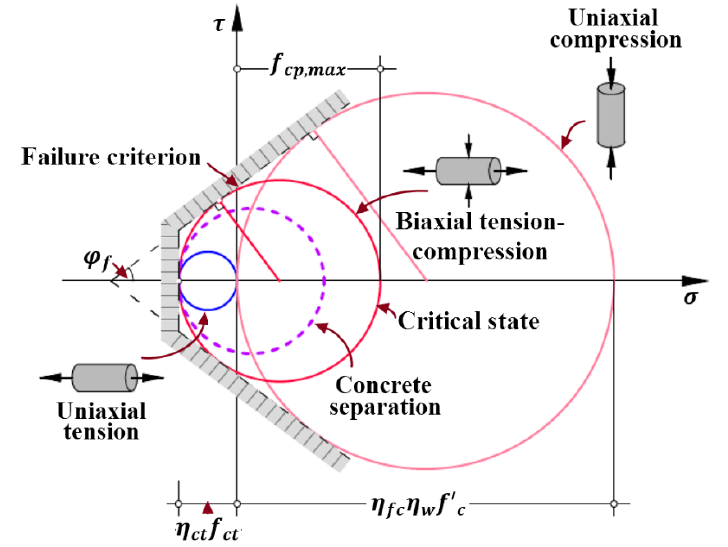
Figure 13. Mohr’s circle for the critical stress conditions of the micro concrete element at the end of FRP reinforcement with mixed mode of cover separation and sliding failure.